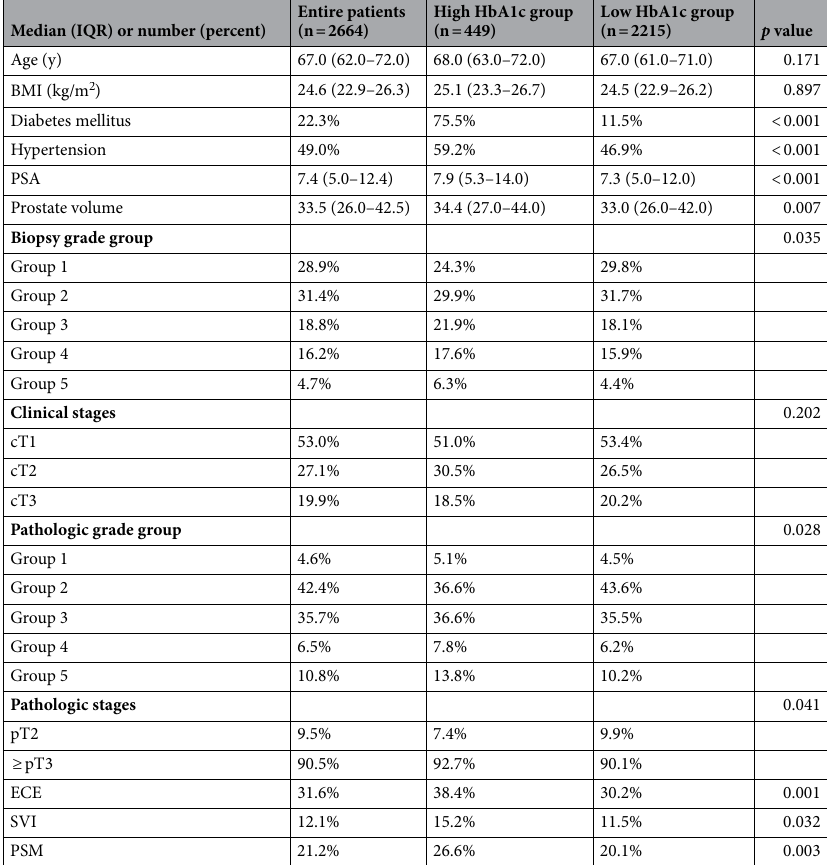
Table 1. Summarization of clinico-pathologic characteristics according to the hemoglobin A1c level. IQR , interquartile range, BMI body mass index, PSA prostate specific antigen, ECE extracapsular extension, SVI seminal vesicle invasion, PSM positive surgical margin.